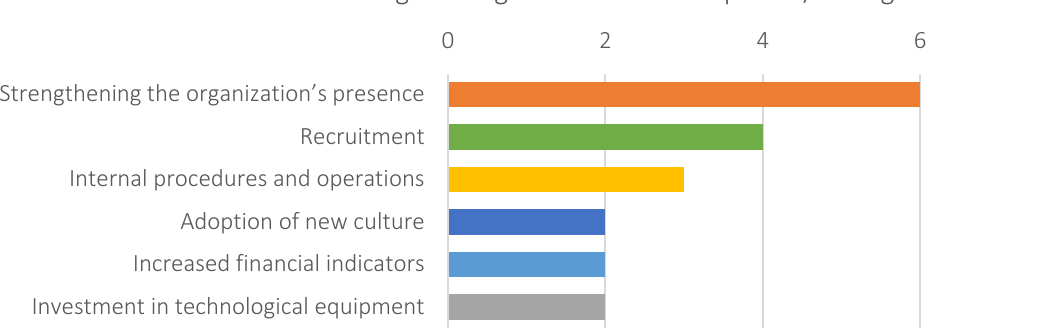
Figure 1b. Internal marketing and organization’s development/coding